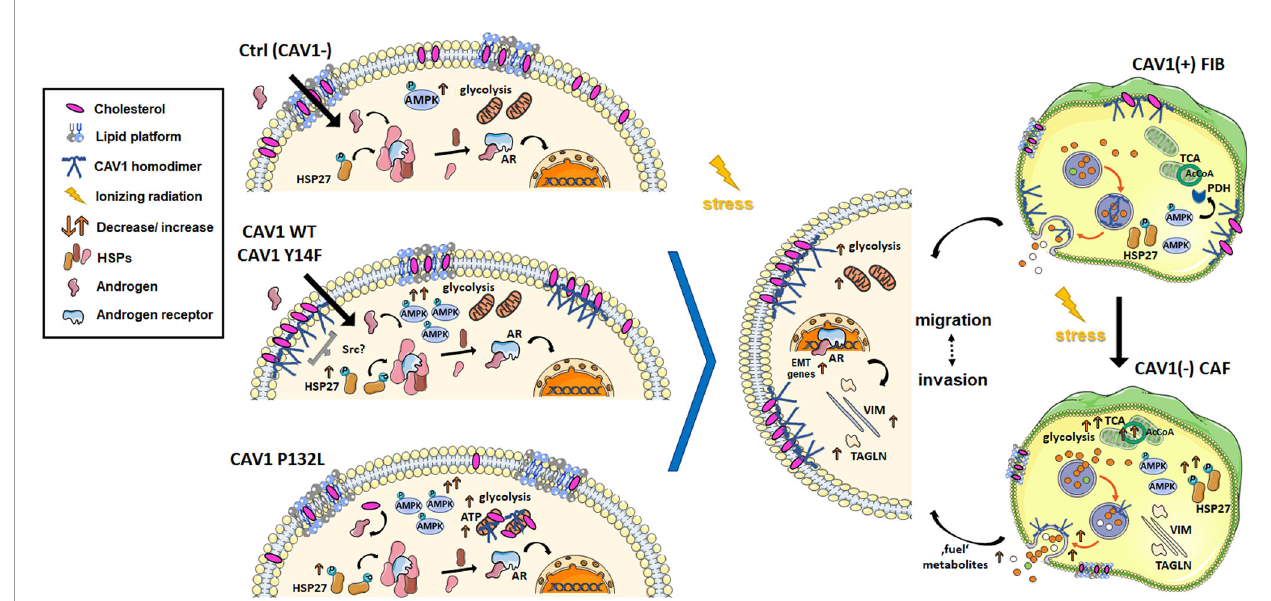
FIGURE 8 | RT-induced stromal alterations decisively impact on adjacent prostate carcinoma (PCa) cells. PCa progression is associated with a critical shift of epithelial – stromal CAV1 expression levels. A re-expression of CAV1 within the malignant epithelial cells could be associated with epithelial-to-mesenchymal transition (EMT), an increased three-dimensional spheroid growth and RT resistance as investigated here. Concerning the related signaling, CAV1 seems to are promote adenosine monophosphate-activated protein kinase (AMPK) and potentially heat shock protein 27 (HSP27) activities, at least in combination with RT. As an assumption, increased HSP27 phosphorylations could foster (androgen-independent) androgen receptor (AR) signaling by displacing other HSPs (e.g., HSP90) from the cytosolic complex, with the AR subsequently squiring into the nucleus modulating target gene (e.g., EMT gene) expressions. It was further shown here, that PTRF (cavin-1)-de fi cient LNCaP PCa cells exhibit long-lasting high-density GM1 ganglioside containing signaling domains that were not affected following a gain in CAV1. In general, upon CAV1 re-expressions, either following increased cellular stress (e.g., by radiation treatment, RT) or by ectopic expression of CAV1, CAV1 can be found at the plasma membrane in non-caveolae plasma membrane domains, so-called scaffolds. Accompanied cholesterol binding reduces the amount of available cholesterol and thus the precursor for the synthesis of the steroid hormones. We therefore speculate that CAV1-dependent receptor signaling and raft- dependent endocytosis might account for signalosome-ampli fi ed signaling events that fi nally foster PCa cells growth, invasion and therapy resistance. Herein CAV1 Tyr14 phosphorylation seemed not to be required for the increased invasion potential of CAV1-expressing LNCaP cells, as it was shown within the present study that CAV1 Y14F-expressing LNCaP cells showed a similar EMT-phenotype but lacked increased three-dimensional spheroid growth. Similarly, non-plasma membrane-localized CAV1 was associated with an EMT phenotype while lacking increased spheroid growth. A gain of epithelial CAV1 could further be linked to increasing metabolic demands that were managed by increased glycolysis levels. Within CAV1 P132L-expressing LNCaP PCa cells, the strongest increase in glycolysis could be observed that, together with increased mitochondrial respiration rates, may compensate a reduced cholesterol utilization due to decreased cholesterol levels. RT-induced HSP27 signaling together with an increased AMPK-dependent signaling might even foster other metabolic processes to generate energy and biomolecules, e.g., fatty acid oxidation. In contrast, an activated fi broblast phenotype either following RT or potentially following ‘ education ’ by adjacent cancer cells will act tumor supporting, which in turn limits applied therapies. Likewise, a loss of stromal CAV1 was already shown to come along with a more reactive fi broblast phenotype as well as increased radioresistance of advanced PCa. Particularly increases in the metabolic potential as shown here following RT, and thus exocytosis of fi broblast-derived factors could not only fuel adjacent cancer cells but even comprise a feeding with resistance factors fi nally fostering PCa progression and therapy resistance. Thus, the loss of stromal CAV1 rather than the gain of epithelial CAV1 accounts more decisively for (radiation) therapy